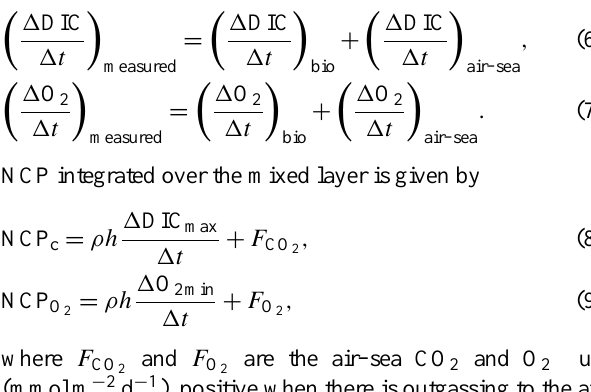
Figure 2. Diurnal cycles of SST, DIC and O 2 from 30 Novem- ber to 4 December 2011. (a) SST ( ◦ C) (black, left vertical axis) and DIC (µmolkg − 1 ) (grey, right vertical axis). The vertical dashed lines indicate the time of sunrise (blue) and sunset (orange). (b) O 2 (µmolkg − 1 ) (black, left vertical axis) and DIC (grey, right vertical